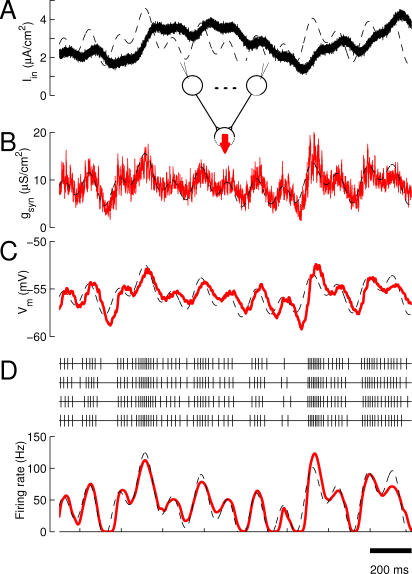
In a Network Scheme with Both SFA and STD, Basic Integration and Spiking Mechanisms in the Postsynaptic Membrane Allow the Postsynaptic Neuron to Encode the Temporal Derivative(A) Current injected into presynaptic neurons (I
in
, solid black line).(B) Synaptic conductance opening in the postsynaptic neuron Gsyn(t).(C) Membrane voltage modulations resulting from synaptic currents and synaptic conductance changes when postsynaptic spiking is inactivated.(D) Sample spike trains (above) and trial-averaged firing rate (below) of the postsynaptic neuron subject to the presynaptic network activity. In all panels, the dashed black curves trace the mathematical derivative of the input, rescaled by the s.d. and recentered by the mean of the plotted signal to allow a direct comparison. The network is exactly as in Figure 4E, with enabled synaptic integration and spiking mechanisms in the postsynaptic neuron. The firing rate curve in (D) was obtained from 400 different simulations and by averaging together normalized bell-curve of s.d. 10 ms centered at the time of spike occurrence. Average postsynaptic firing rate was 64 Hz.